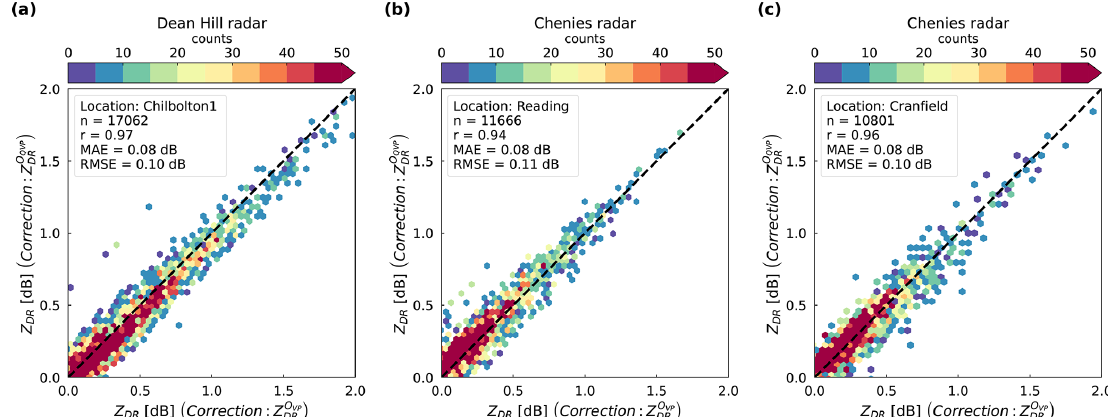
Figure 8. Scatterplots between calibrated Z DR measurements using VPs and QVPs. Each plot represents radar Z DR measurements at different locations and filtered using precipitation and intensity classifiers gathered from disdrometers.